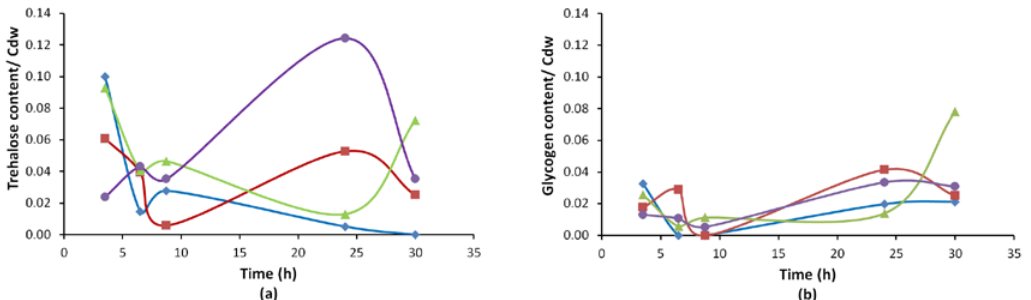
Figure 5. Trehalose ( a ) and glycogen ( b ) contents of M8FE and 905 (mg / mg) under control and iron stress conditions ( (cid:95) 905 under control condition, (cid:4) 905 under iron stress condition, (cid:78) M8FE under control condition, (cid:8) M8FE under iron stress